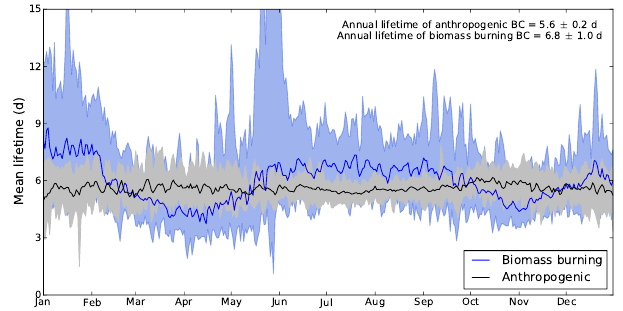
Figure 3. Annual mean global lifetime ( ± standard deviation) of the global anthropogenic and BB BC from our combined FEI- NE + MACCity simulation. The results show minimum, average, and maximum daily lifetimes of BC (both for anthropogenic and BB) for the period